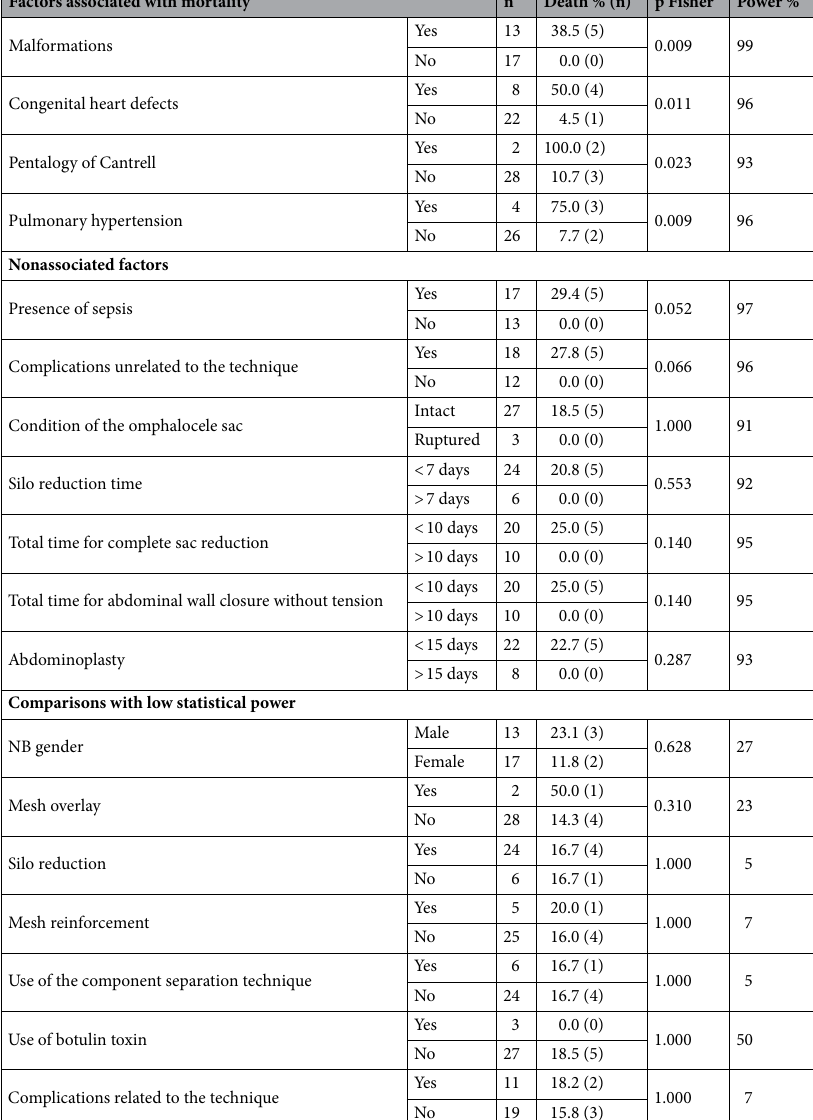
Table 3. Factors potentially related to the mortality of the study subjects.